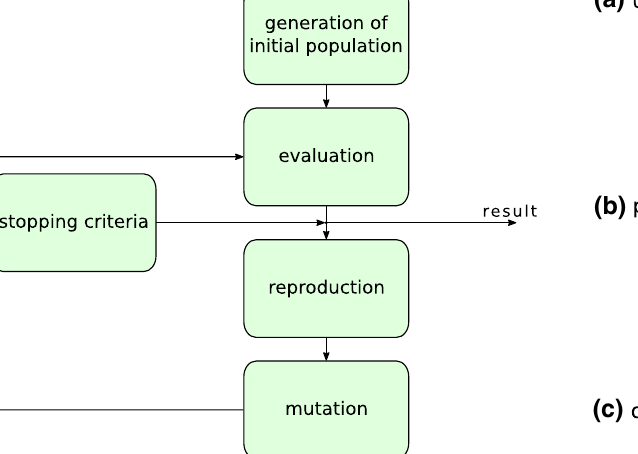
Fig. 3 Scheme of the genetic algorithm